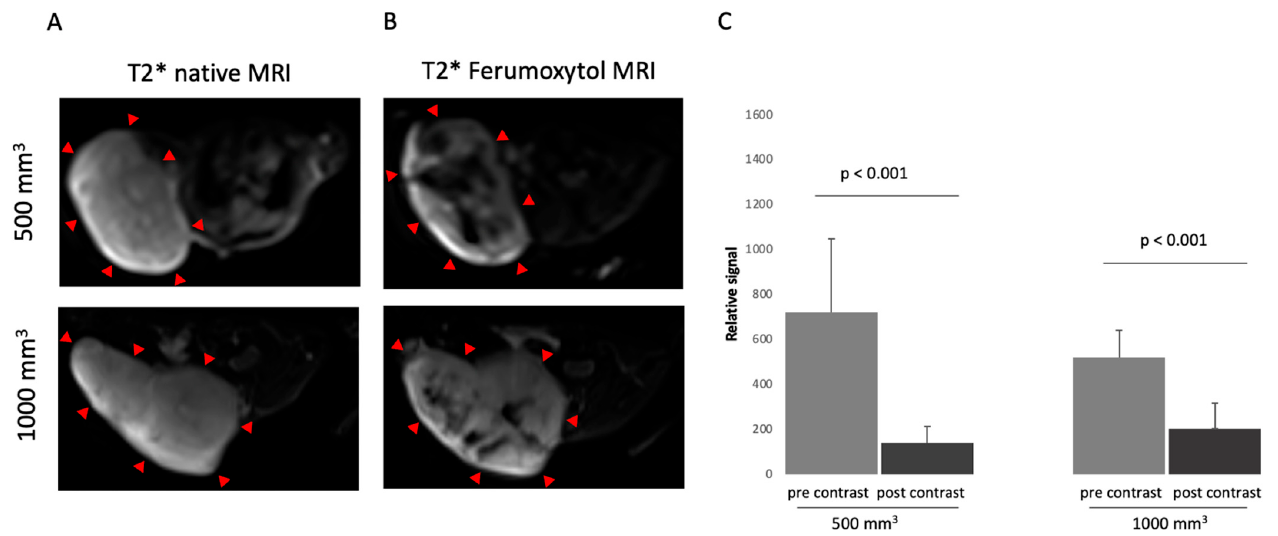
Figure 2. MRI images of prostate cancer in xenograft model of two different tumor sizes, 500 mm 3 and 1000 mm 3 . ( A ) shows a representative native MRI image of a T2*-weighted sequence from the mouse that developed a tumor with a volume of 500 mm 3 (top) and 1000 mm 3 (bottom) in the scapula area of the mouse. Red arrows are pointing at the tumor. ( B ) shows a post-contrast T2*-weighted sequence with ferumoxytol from a tumor-bearing mouse after 24 h. Top: 500 mm 3 . Bottom: 1000 mm 3 . Red arrows show the tumor. ( C ) shows the analysis of MRI images (T2*-weighted sequence) before and after contrast agent administration (ferumoxytol) in two different tumor volumes (500 mm 3 and 1000 mm 3 ). A total of 14 animals per group were studied ( n =